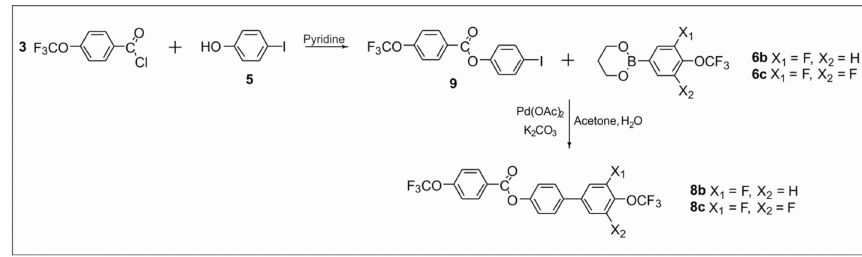
Figure 3. Synthesis of ester derivatives 8b and 8c (variant B).